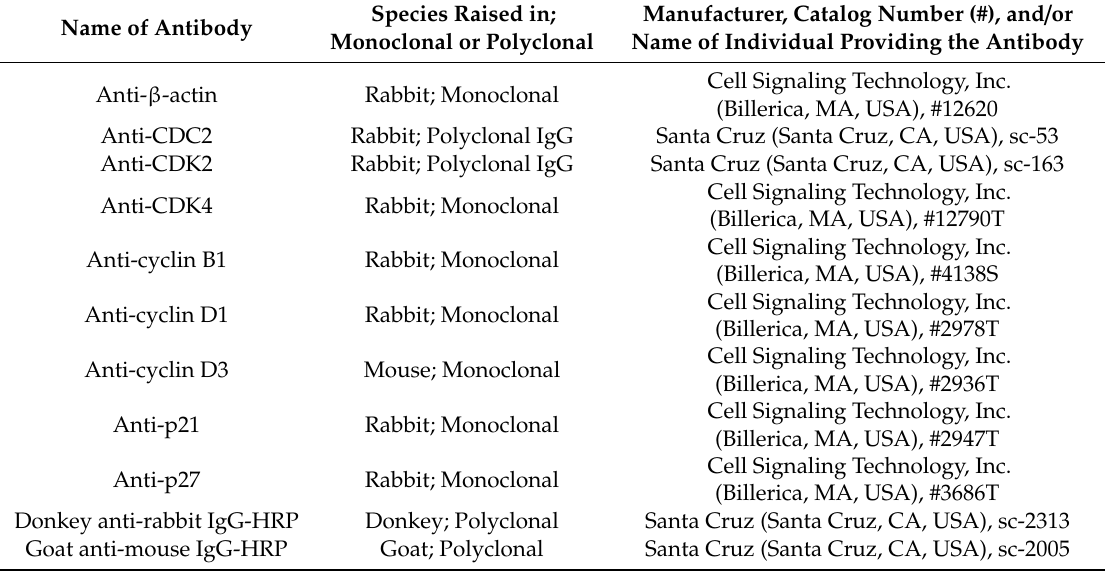
Table 1. Antibodies used in the